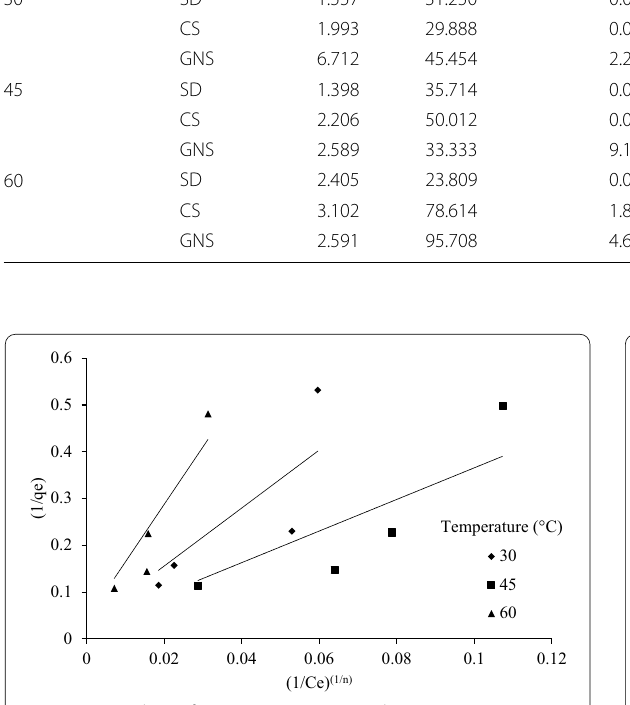
Fig. 7 Sips isotherm for SD at 30 °C, 45 °C and 60 °C Fig. 8 Sips isotherm for CS at 30 °C, 45 °C and 60 °C